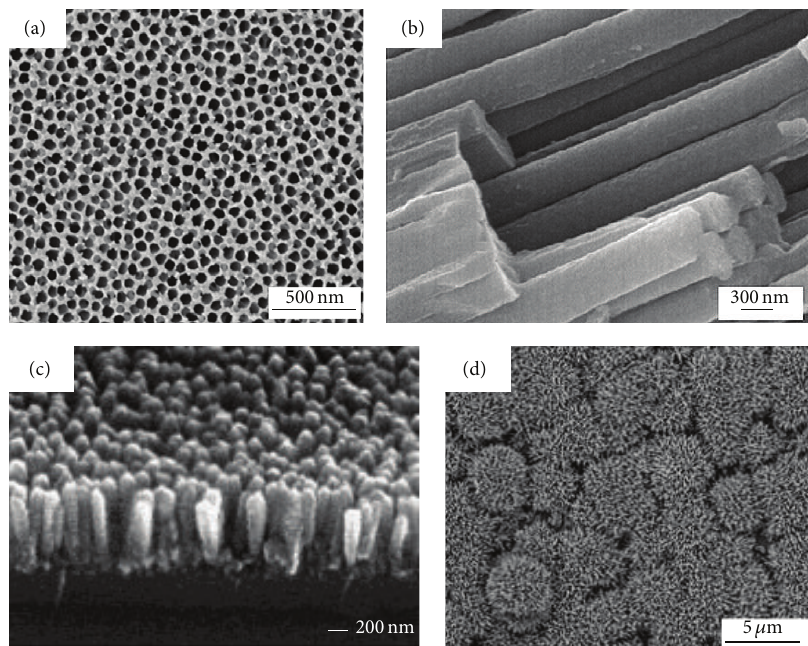
Figure 2: (a) FESEM image of the template (anodic alumina membrane) [20], (b) FESEM image of the synthesized TiO 2 nanorod arrays [20], (c) FESEM image of anatase TiO 2 nanorods [21], and (d) FESEM image of TiO 2 nanorod film [22].